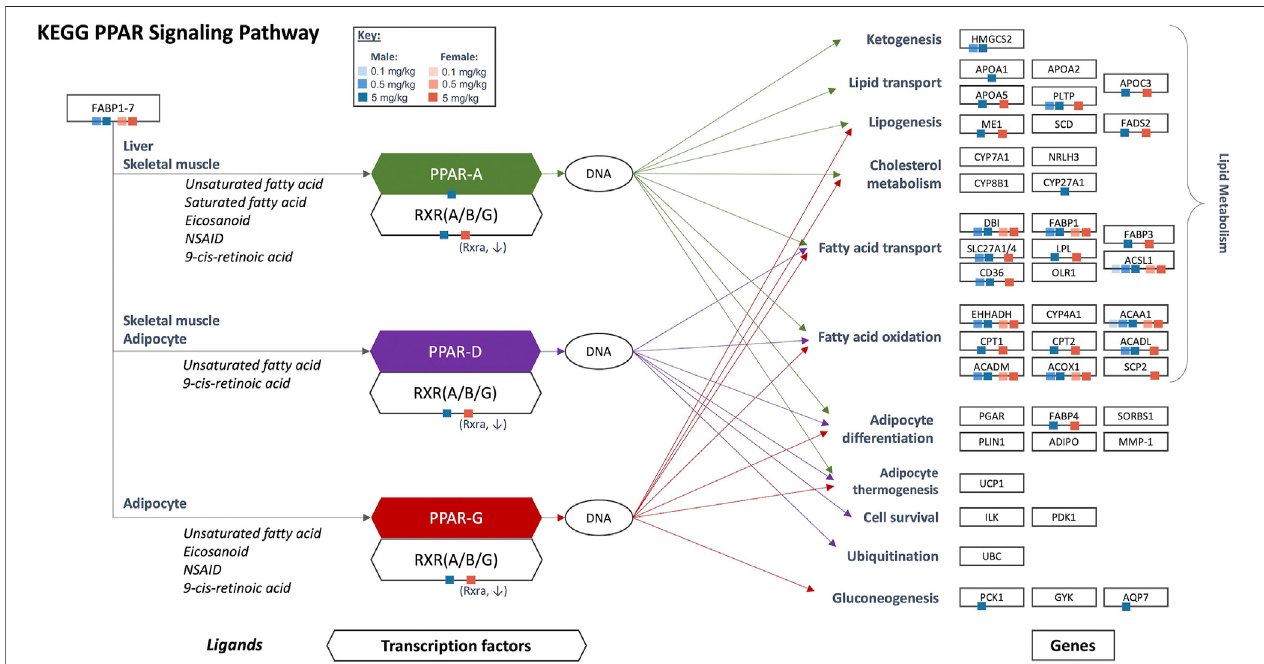
FIGURE2| Signi fi cantDEGsthatareapartoftheKEGGPPARsignalingnetworkinHFPO-DA-exposedmale and femalemice.Ligands,transcriptionfactors, and genes, as related to PPAR α / γ / δ signaling, are shown according to the KEGG database. Individual PPAR signaling genes that are signi fi cantly differentially expressed in the present study are notated by color-coded squares by sex and concentration. Arrows show the target genes corresponding to each PPAR isoform: green = PPAR α , purple = PPAR δ , red = PPAR γ . Figure adapted from Chappell et al. (2020). KEGG, Kyoto Encyclopedia of Genes and Genomes; PPAR, peroxisome proliferator- activated